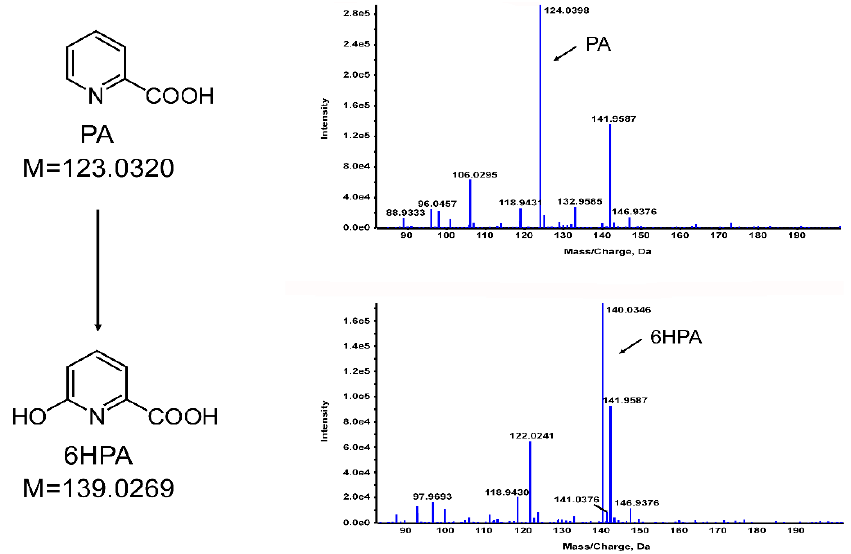
Figure 5. LC/TOF-MS profiles of PA and 6HPA.